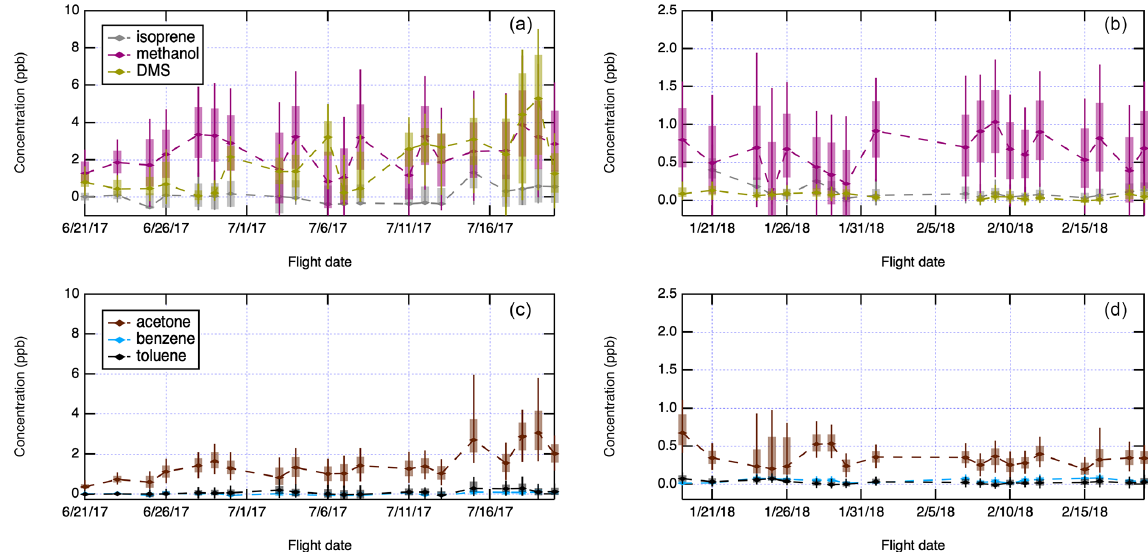
Figure 7. Summary of trace gas chemistry measurements acquired with the PTR-MS aboard the G-1 aircraft during ACE-ENA. Measure- ments at altitudes from 1000 to 3000m. Boxes are centered on daily medians, box boundaries extend between the 25th and 75th percentile, and whiskers extend between the 10th and 90th percentile. (a, c) IOP 1 measurements. (b, d) IOP 2 measurements.